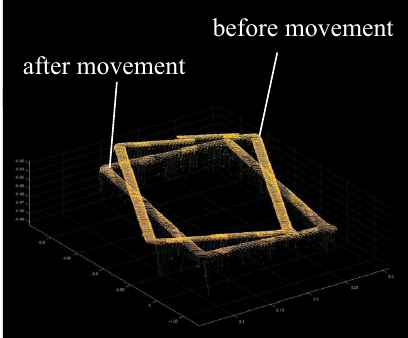
Figure 6. Recorded point clouds from small-scale experiment before and after moving the print plate.